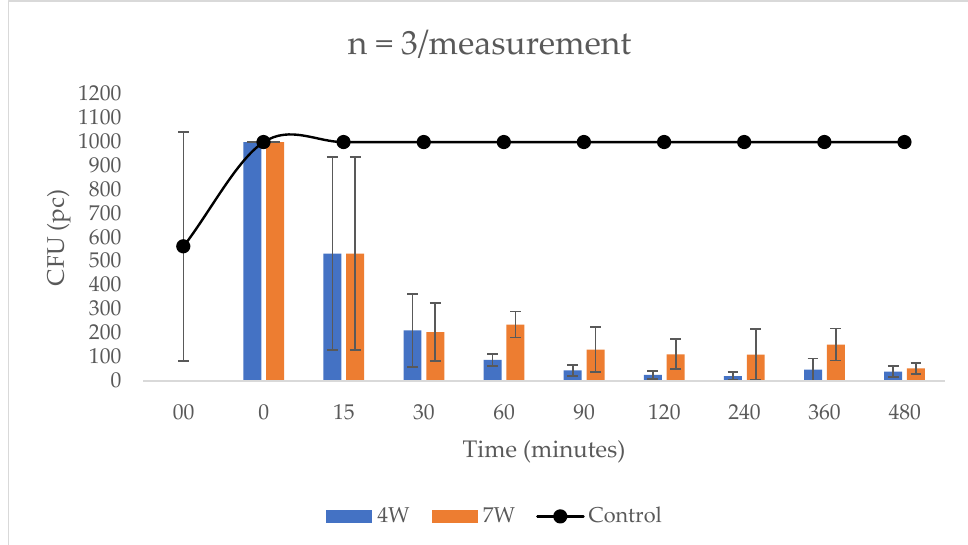
Figure 2. Effect of organic contaminant on photocatalyst layer treated and untreated surface at a distance of 300 cm under illumination with 4 W and 7 W lamps. For samples taken after 15 min, the CFU reduction was not yet significant (78.8% after 30 min for 4 W and 79.5% for 7 W).